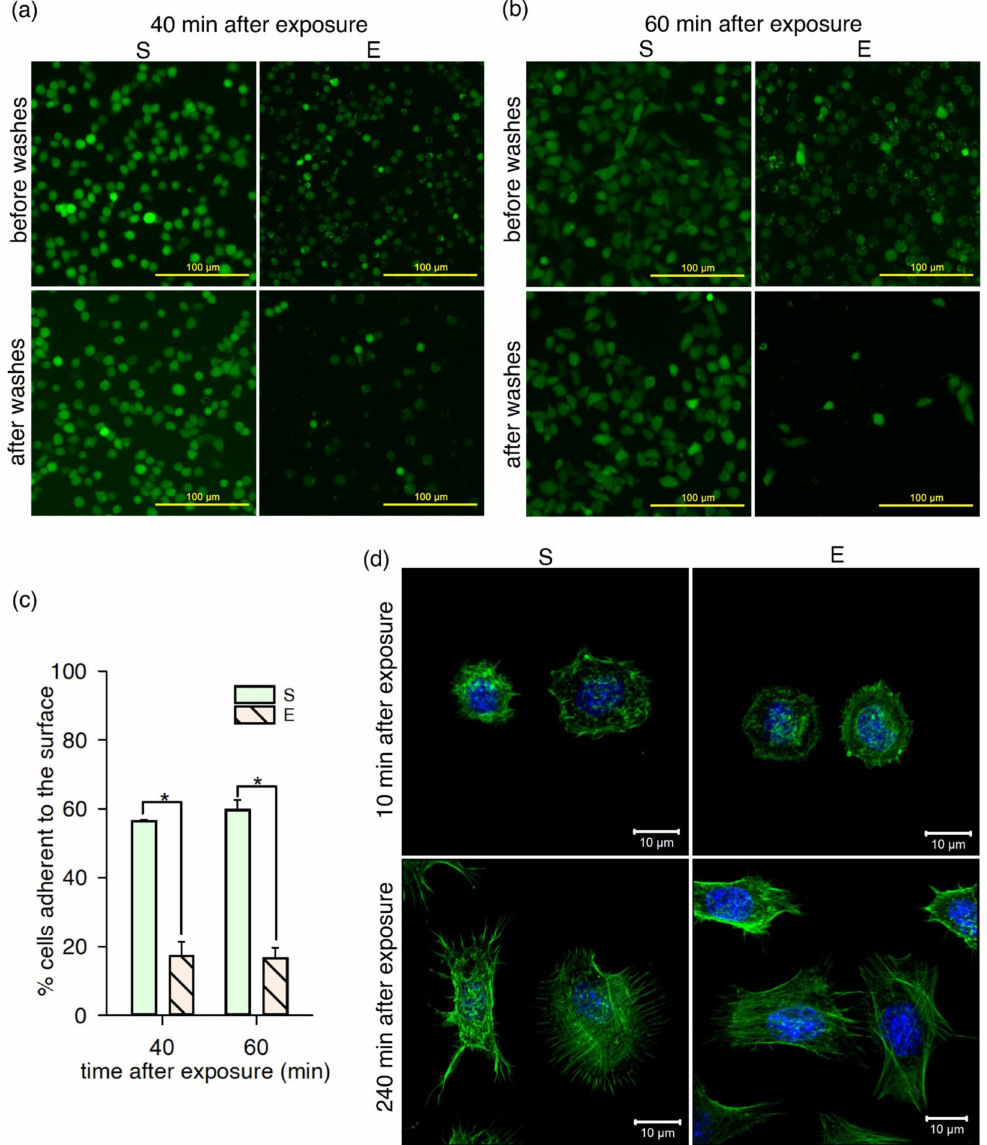
Figure 3. Adhesion and actin cytoskeleton of TM3 cells. S: sham-exposed cells. E: nsPEF-exposed cells. ( a , b ) Wash assay: TM3 cells were stained with calcein-AM before nsPEF exposure, seeded on the plastic surface, and visualized by epifluorescence microscopy before and after washes. The wash assay was carried out at 40 ( a ) and 60 min ( b ) after nsPEF exposure. Healthy intact cells were observed without the exposure (S samples, left panels), and two populations were visible after nsPEF exposure (E samples, right panels): cells with high calcein fluorescence intensity that attached to the surface, and cells with a diminished calcein staining that were mostly washed out. The yellow bar represents 100 µ m. ( c ) Differences in cell attachment between sham- and nsPEF-exposed samples were detected in the wash assay at 40 min and 60 min after treatment. The bars represent the percentage of cells that adhered to the surface (mean value ± SD of three biological replicates, each in three technical repetitions). Asterisk represents the significant difference between the fractions of cells adhering to the surface in sham- and nsPEF-exposed samples at 40 and 60 min (* p < 0.001, Student’s t -test). ( d ) Actin cytoskeleton stained with phalloidin-Alexa Fluor 488 (green), and the nucleus stained with Hoechst (blue). The cells were fixed after 10 min (upper row), and 240 min (lower row), post-treatment, and visualized under CLSM. The white bar represents 10 µ